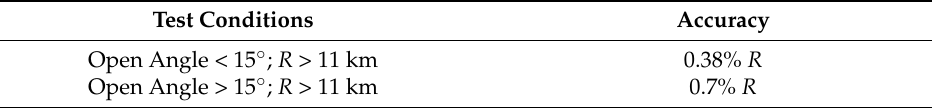
Table 4. Measurement of the precision.